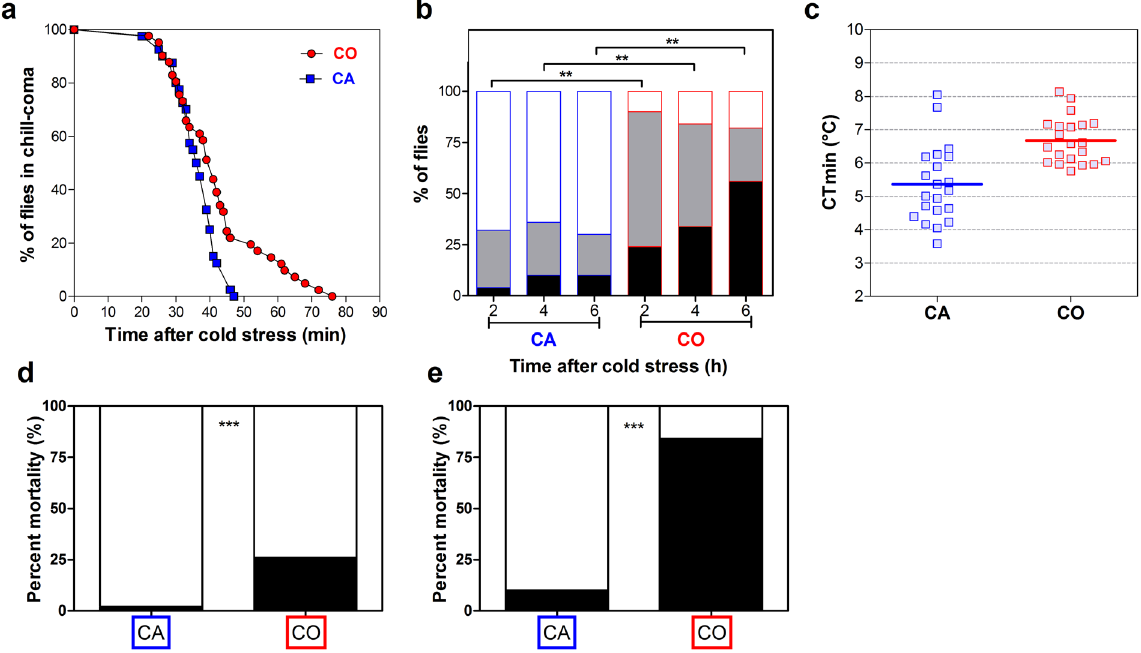
Figure 2. ( a ) Comparison of chill coma recovery dynamics in CA (blue squares) vs. CO (red circles) flies. Time to recover from chill coma was monitored in flies recovering at 25 °C after 9 h of chronic cold stress at 0 °C ( n = 40). ( b ) Climbing activity monitored in CA vs. CO flies recovering flies after 2, 4 and 6 h following 9 h at 0 °C. Flies were categorized as fit (white part) or recovering (grey part) or injured (black part) ( n = 50). ( c ) Critical thermal minimum (CT min ) in the two groups tested. The horizontal lines indicate the mean value ( n = 21). Mortality rate (black part) in CA and CO flies recovering for 24 h at 25 °C after 9 h of chronic cold stress at 0 °C ( n = 50) ( d ) or 2 h of acute cold stress at − 3.5 °C ( n = 50) ( e ). Symbols ( * ) indicate a significant difference ( p < 0.05).